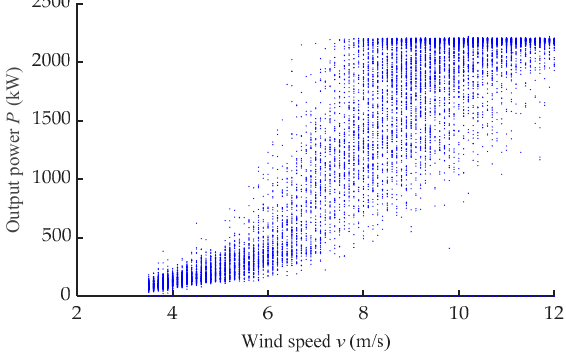
Figure 2. Scattered relationship between wind speed and output power.